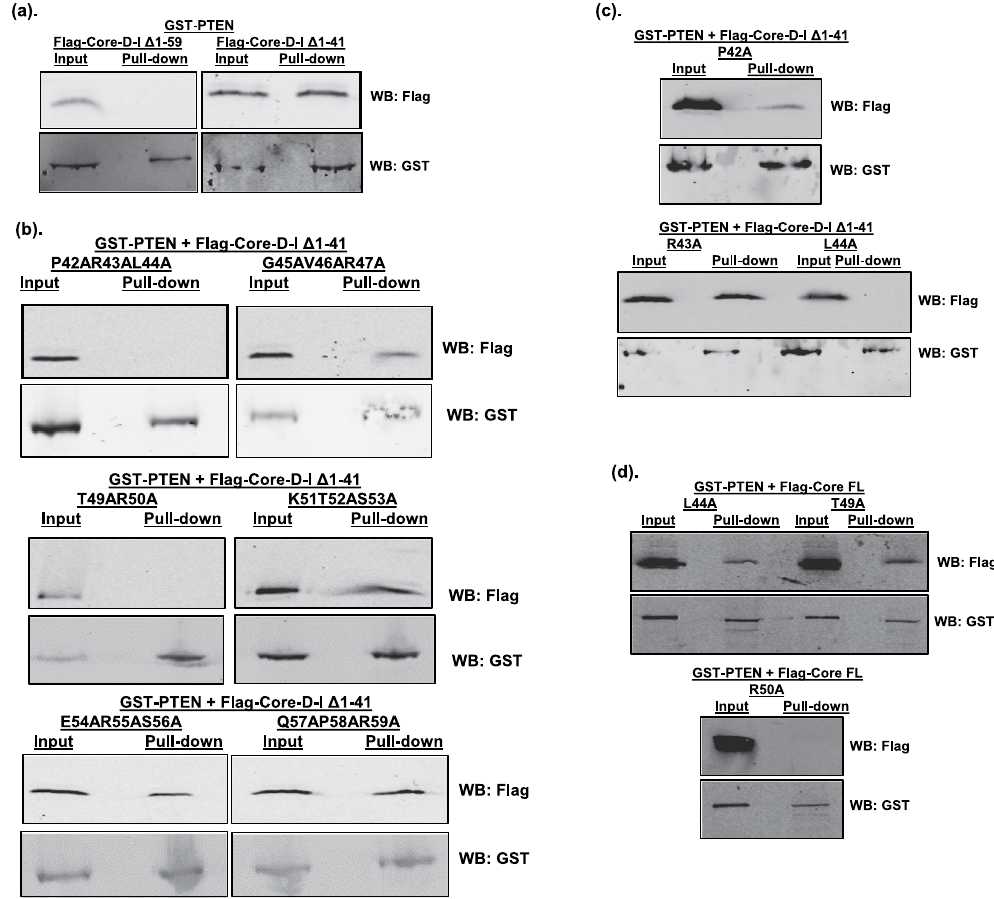
Figure 6. HCV core R50 is the key residue for interaction with PTEN. Huh-7 cells were co-transfected with GST-PTEN-expressing plasmid, together with plasmids expressing truncated HCV core, either wild-type ( a ), with multiple ( b ) or single ( c ) amino acid mutations, or full-length (FL) HCV core with single amino acid mutations ( d ). The core proteins have a Flag-tag at the N-termini. At 48 hours after transfection, cell lysates were subjected to GST pull-down assay. Input and pull-down products were analyzed by Western blotting (WB) using anti-Flag and anti-GST antibodies, respectively. Western blots for Flag-HCV core and GST-PTEN in Fig. 6b were cropped images from full-length blots to ensure lane alignment and the full-length blots can be found in Supplementary